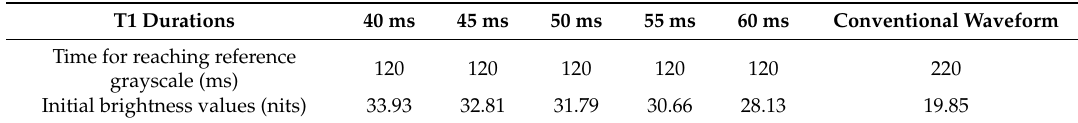
Table 1. Change value of EPD brightness in T2.